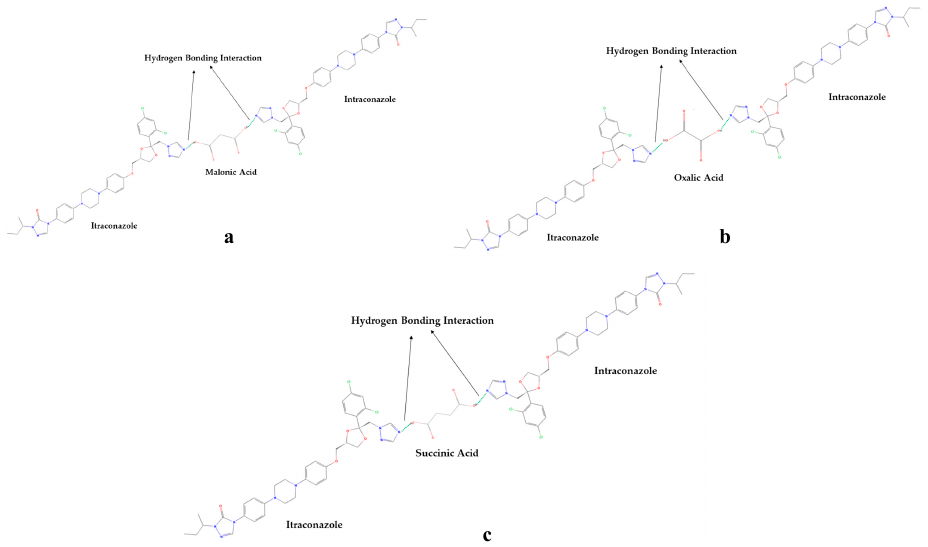
Figure 5. Hypothetic trimers can be formed from co-crystal of ITZ and dicarboxylic acids with various carbon chain lengths, ( a ) ITZ-Malonic Acid, ( b ) ITZ-Oxalic Acid, and ( c ) ITZ-SCU. Adapted from data presented originally in Ref. [59].